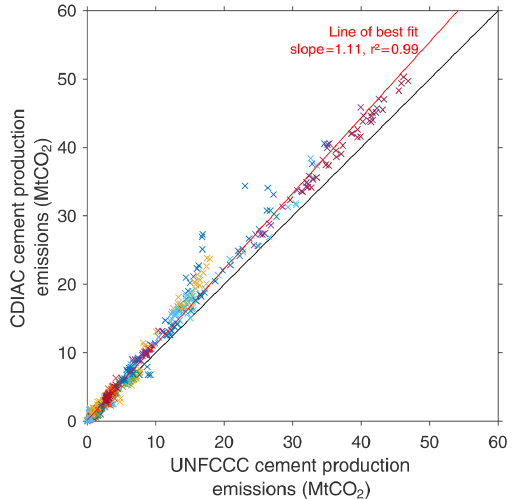
Figure A2. Comparison of CO 2 emissions in 43 countries as esti- mated by CDIAC (Boden et al., 2013) and those officially reported to the UNFCCC, 1990–2012 (UNFCCC,